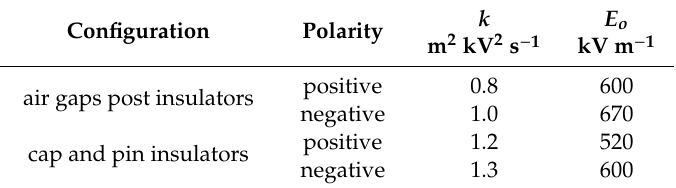
Table 1. Values of k and E o for practical configuration [23]. Configuration